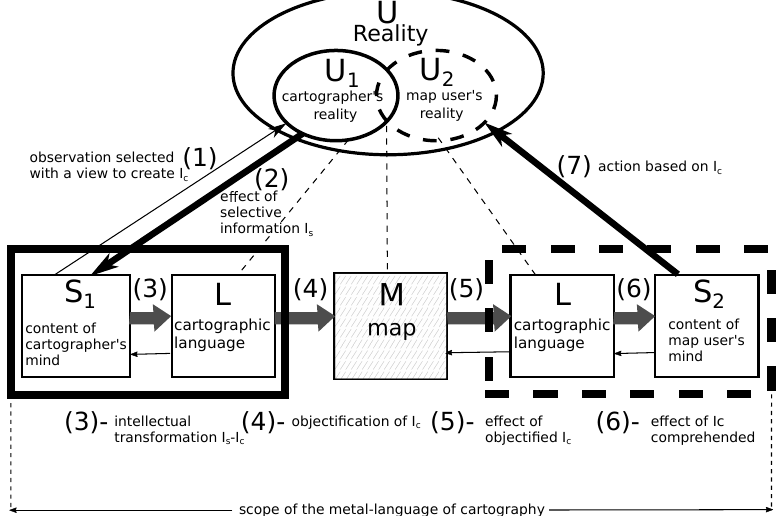
Figure 2. Simplified version of the cartographic communication model by Kolacny